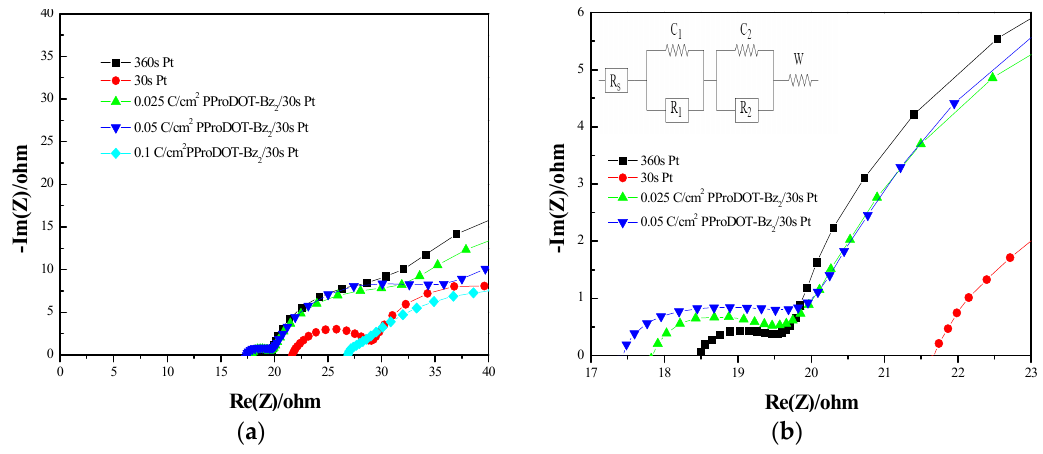
Figure 4. ( a ) Nyquist plots of the DSSCs based on 360 s Pt, 30 s Pt, 0.025 C/cm 2 PProDOT-Bz 2 /30 s Pt, 0.05 C/cm 2 PProDOT-Bz 2 /30 s Pt, and 0.1 C/cm 2 PProDOT-Bz 2 /30 s Pt counter electrodes; ( b ) an enlarged graph of ( a ). Table 2. The resistance and capacitance of equivalent circuit for DSSCs.